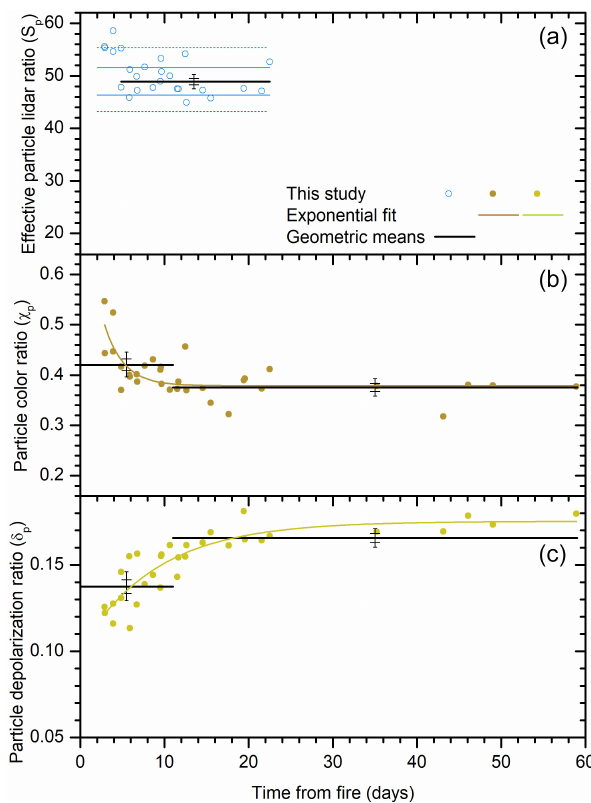
Figure 2. Particle optical properties during the first 60d after the fire. Black error bars show standard error and the double-sided 95% probability range of the geometric means. (a) Particle lidar ratios for 532nm, where data points with fitting error exceeding 25% are dis- carded. The black line shows the geometric mean after day 4, and the full and dotted blue lines show the standard deviation and the double-sided 95% probability range of the distribution. (b) Parti- cle color ratio (1064nm divided by 532nm wavelength backscat- tering) with exponential fit ( R 2 = 0 . 48, P < 10 − 10 ); (c) particle depolarization ratio with exponential fit ( R 2 = 0 . 76, P < 10 − 10 ). The color and depolarization ratios were divided into two equal groups by number of observations to illustrate the highly signifi- cant changes with time of the optical properties, where the long and short error bars are the standard error and the double-sided 95% probability range of the geometric